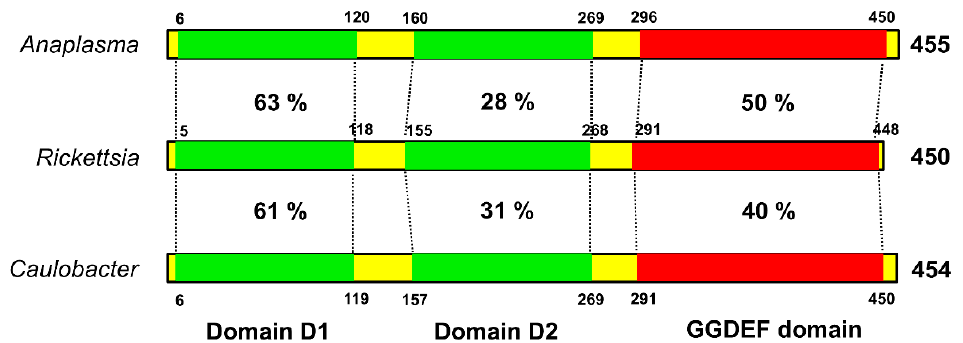
Figure 2. The conserved domain architecture of rickettsial PleD. The rickettsial PleD domains (receiver domain 1, adapter domain 2, and GGDEF domain) were identified using blastp and compared with their counterparts in Anaplasma and Caulobacter. The receiver domain 1 and GGDEF domain of Rickettsia showed higher sequence identity with those present in Anaplasma and Caulobacter , whereas the adapter domain 2 is relatively less conserved. Sequence identity is presented as percentage. The numbers above/below the bars correspond to domain coordinates.